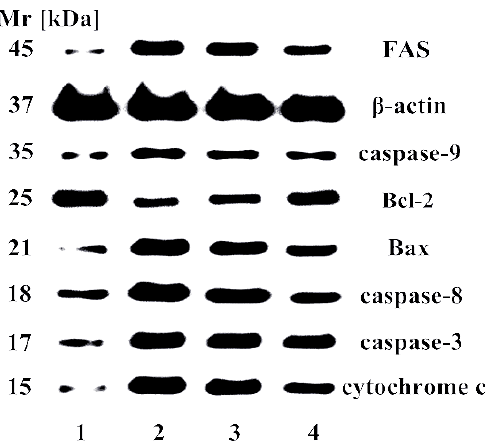
Figure 7. Western blotting of 10f on the expression of apoptosis-related proteins in Bel-7402 cells. 1: